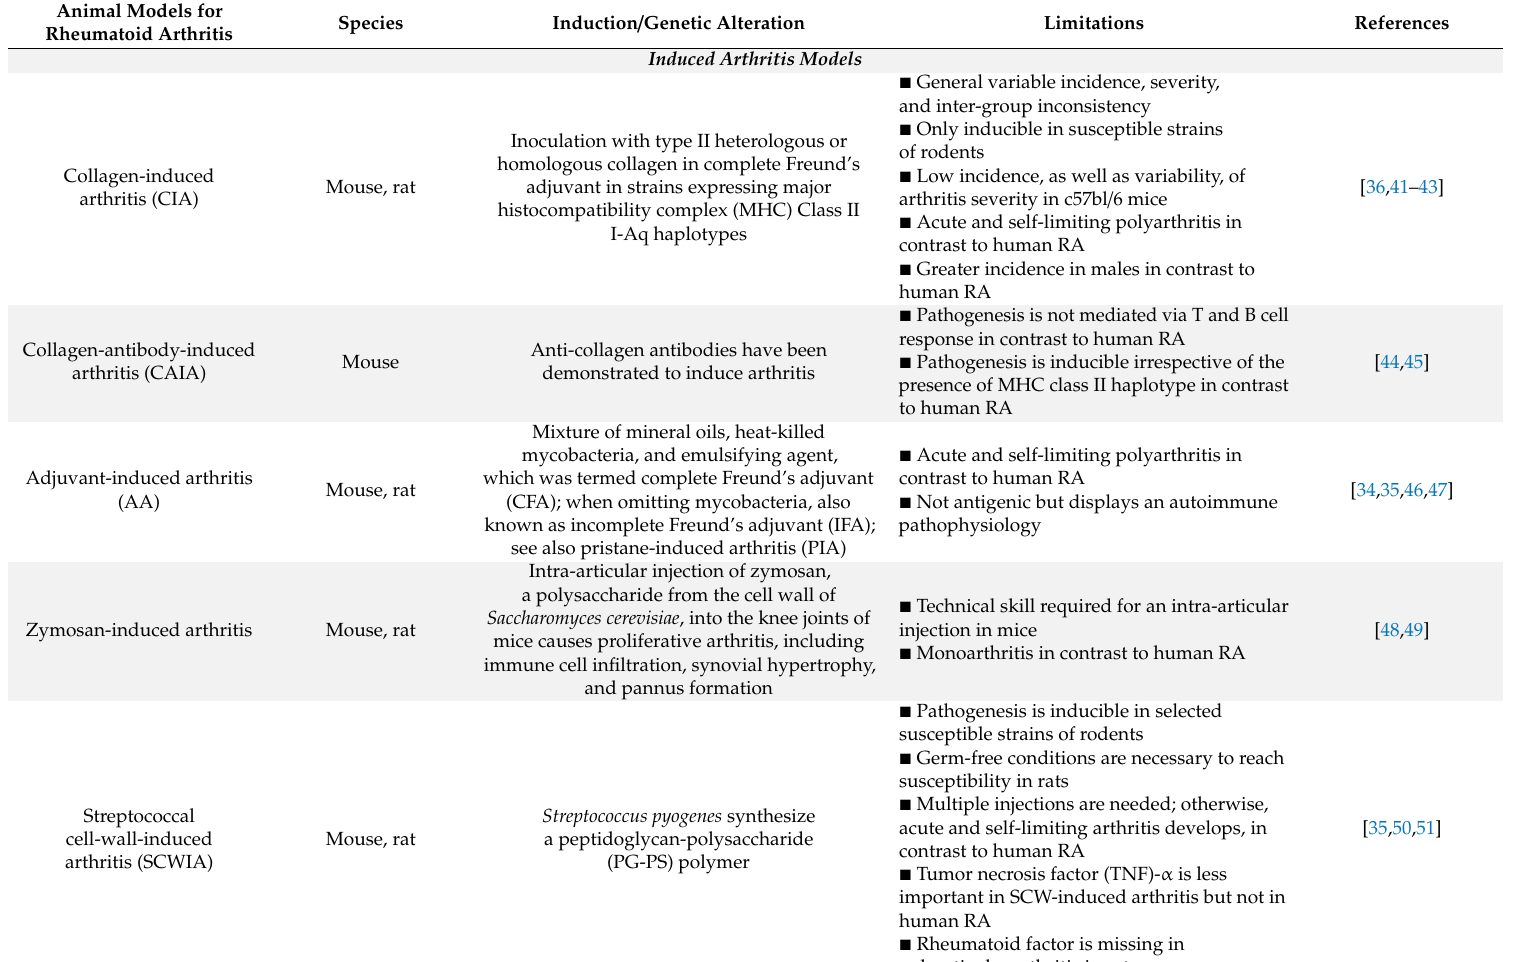
Table 1. Selected rodent models for rheumatoid arthritis (as reviewed in Reference [34–36]). Animal Models for Rheumatoid